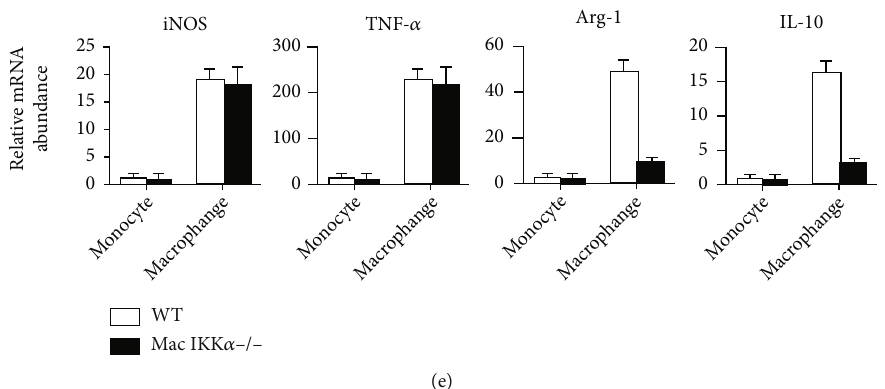
Figure 5: The di ff erence between macrophages of WT mice (WT M Φ s) and Mac IKK α − / − mice (KO M Φ s). Macrophages were induced by injecting thioglycollate broth into the peritoneal cavity of mice for 3 days. (a) The percentage of CD14+ and F4/80+ KO M Φ s was smaller than that of WT M Φ s assessed by fl ow cytometry analysis. (b) Representative fl ow cytometry results showed that the proportion of CD206+ and F4/80+ KO M Φ s was smaller than that of WT M Φ s. (c) Representative images and quanti fi cation of Western blot analyses for expression of iNOS and TNF- α as M1 markers and Arg-1 and IL-10 as M2 markers. (d) There was no signi fi cant di ff erence in the expression of iNOS and TNF- α , while the WT M Φ s produced more Arg-1 and IL-10 compared with KO M Φ s. Data are presented as the mean ± s : d . ∗ P < 0 : 05 versus Mac IKK α − / − mice; n = 3 , independent t -test. (e) The mRNA abundance for iNOS, TNF- α , Arg-1, and IL- 10 in monocytes and macrophages isolated from WT mice or Mac IKK α − / − mice was assessed; data are presented as the mean ± s : d . ∗ P < 0 : 05 versus Mac IKK α − / − mice; n = 3 , independent t